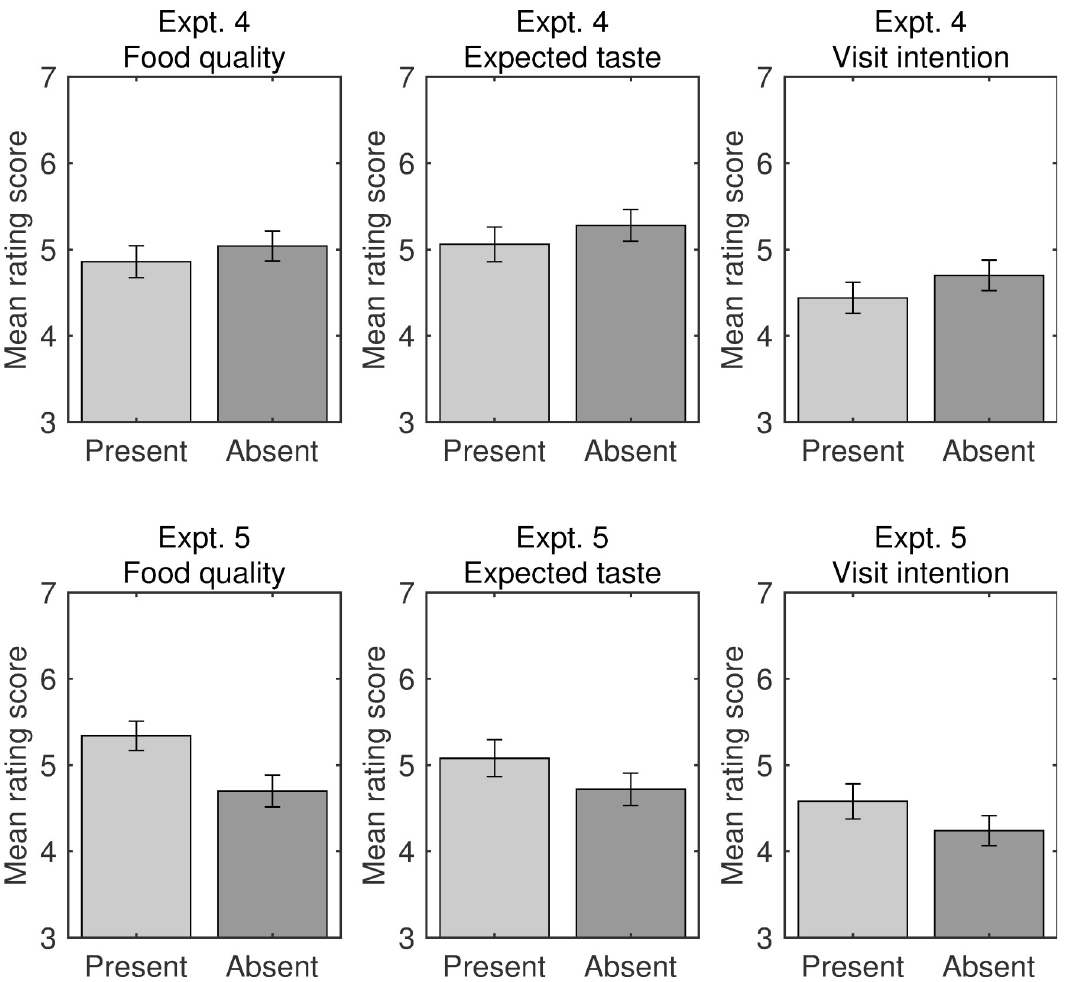
Fig 9. Evaluations of food shops in Experiments 4 and 5. Bar plots for visit intention, expected taste, and food quality ratings and calendar type (Gregorian in Experiment 4 and Japanese in Experiment 5) are shown separately for the label present and label absent conditions. Error bars indicate standard